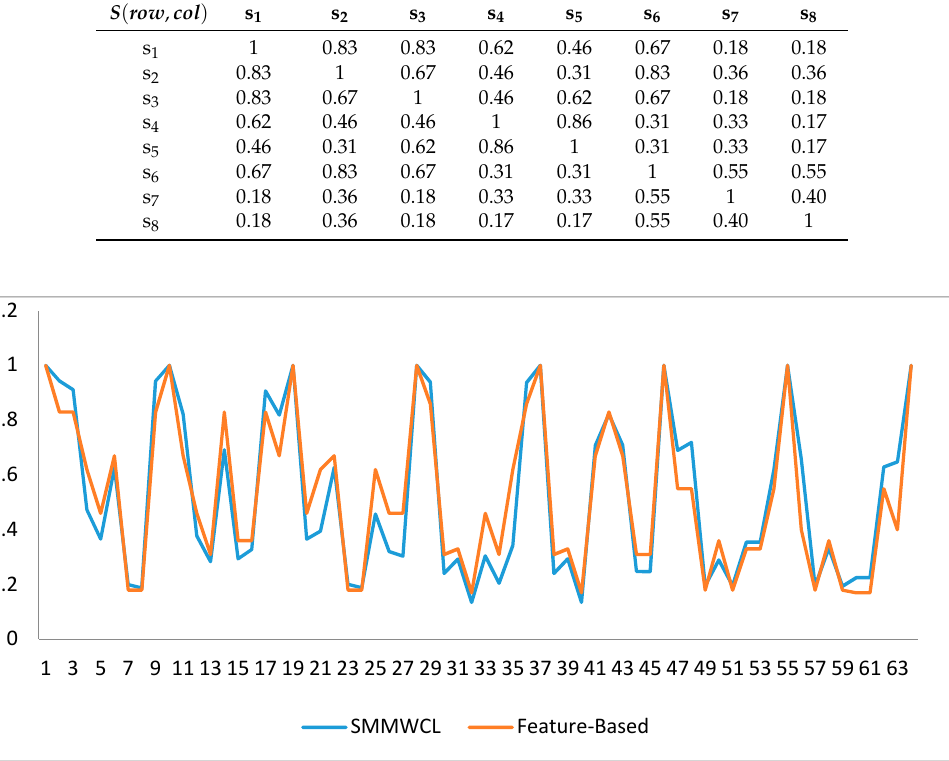
Figure 4. Line chart in which semantic similarities are from Tables 7 and 8.